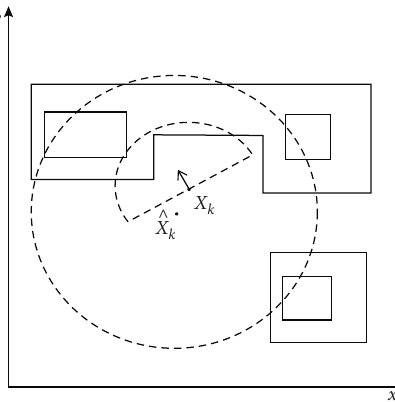
Figure 3: Map of the position and surrounding characteristics of unmanned vehicles.